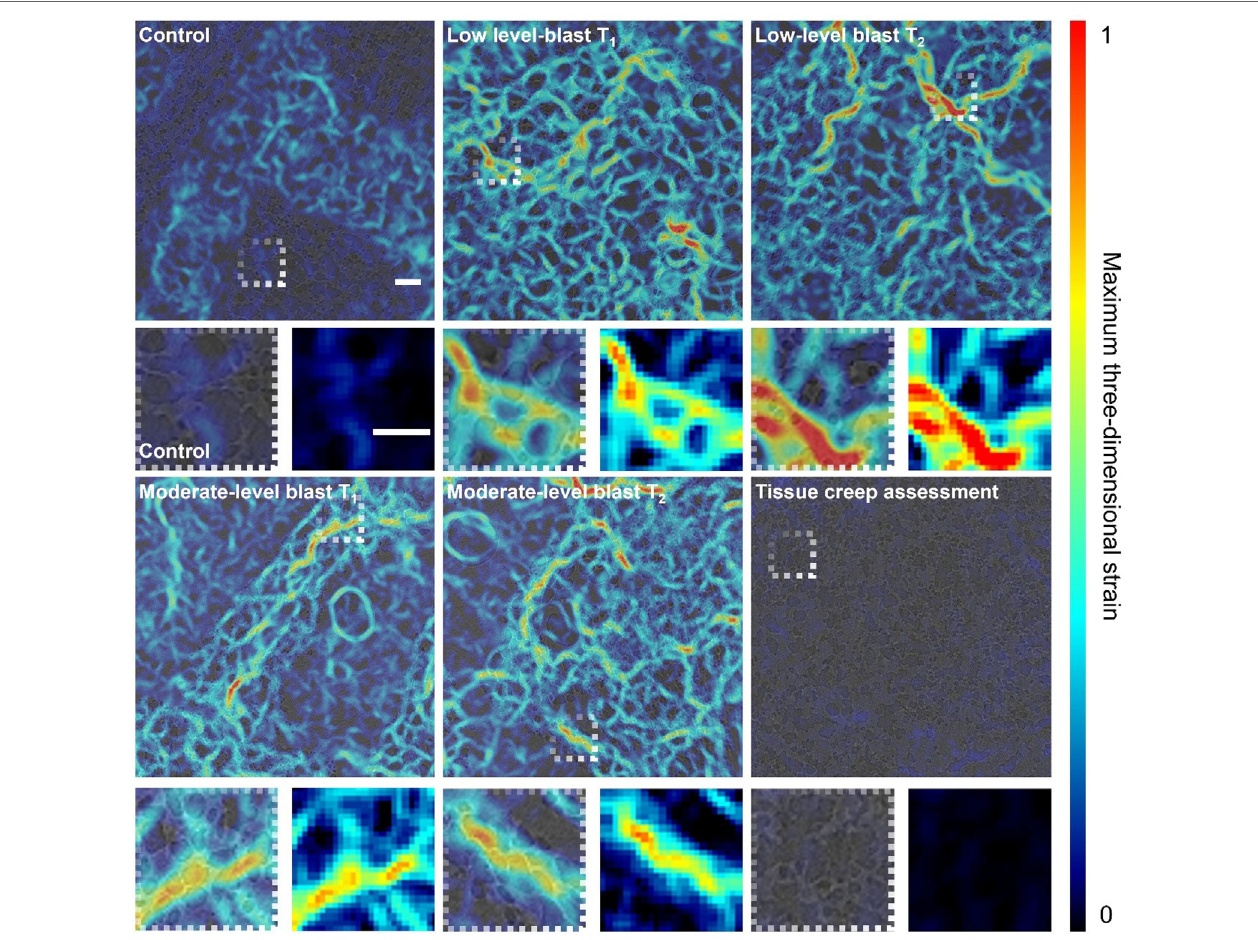
FigUre 6 | Digital volume correlation results displaying the maximum three-dimensional strain at a given plane within the lung volume for each loading case: control, low-level blast and moderate-level blast. T 1 and T 2 denote repeat experiments. In addition, one blast specimen was scanned twice with a time delay between scans to highlight the maximum level of tissue creep during the imaging process as a proxy measure of noise and error in strain measurement. Scale bar indicates 200